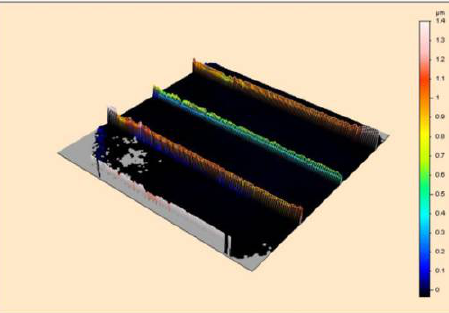
Figure 5. The images of 600 nm SiO 2 thin films deposited on an array substrate measured by surface profilometer.